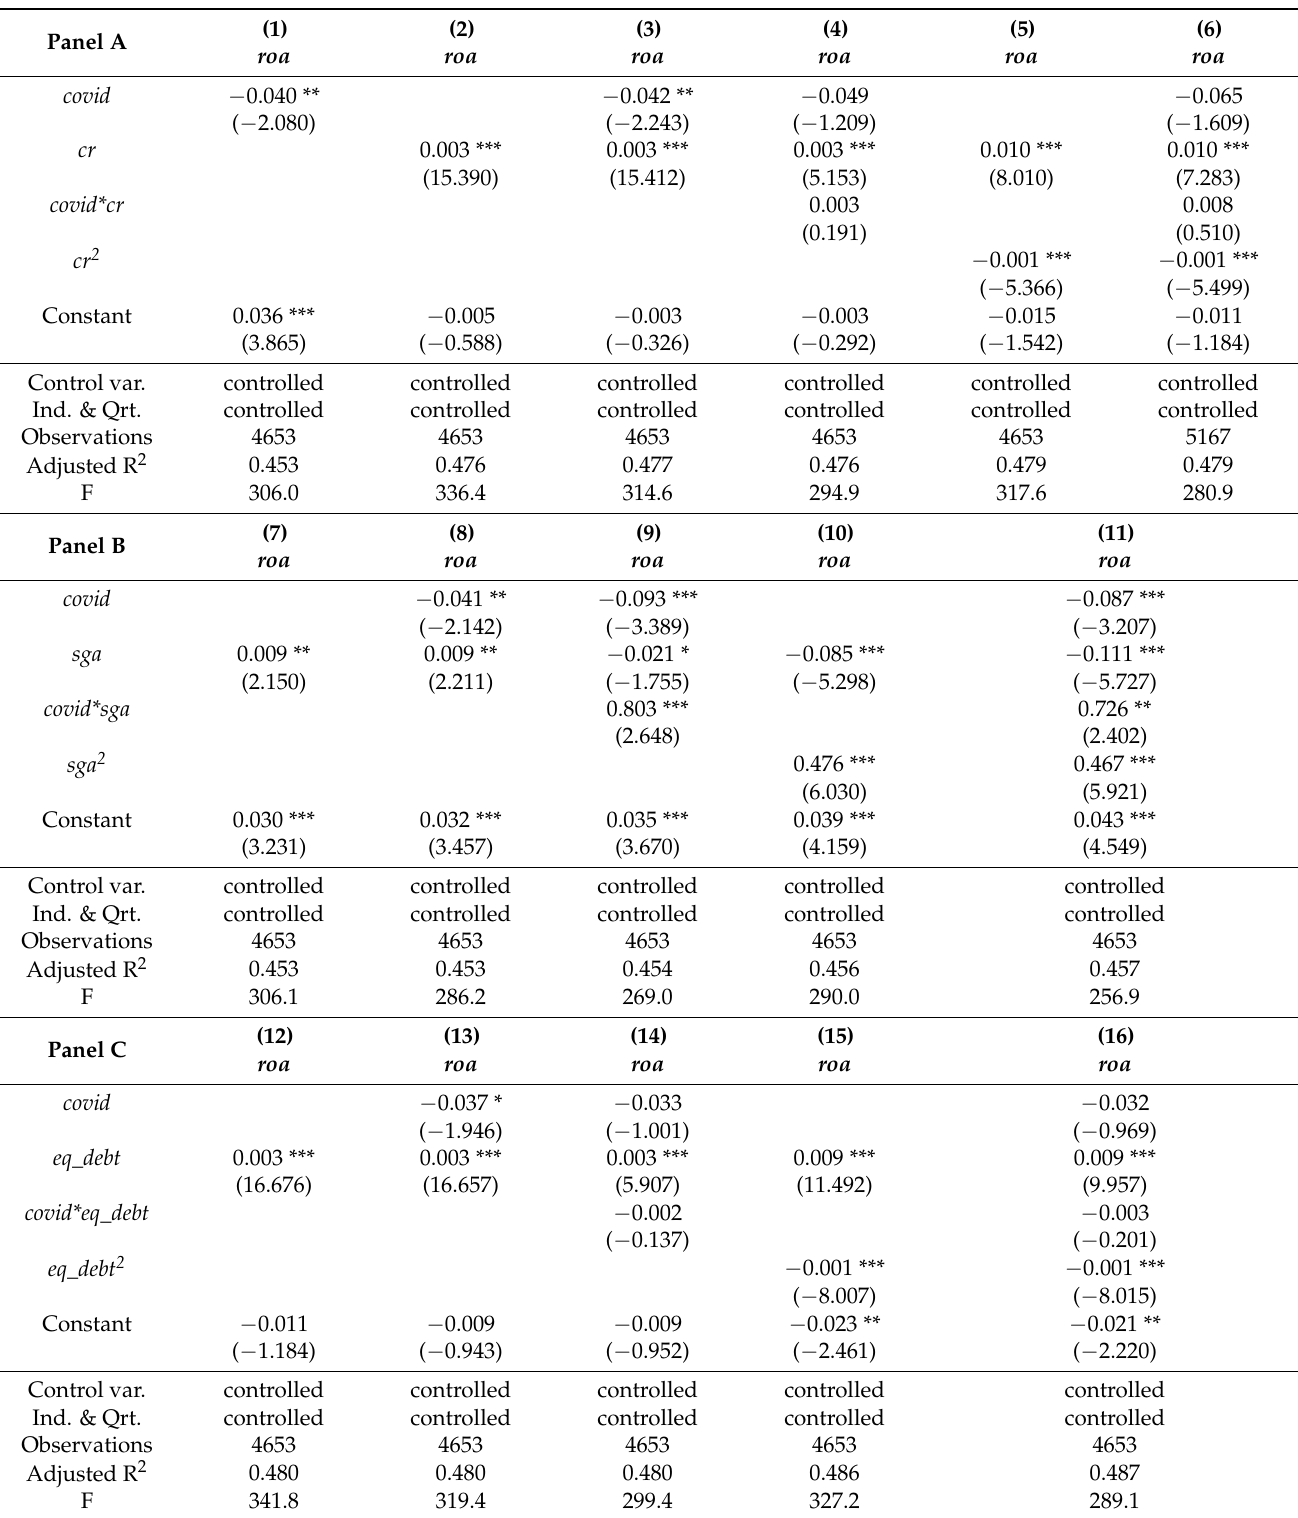
Table 7. Regression Results for H2: Financially unconstrained